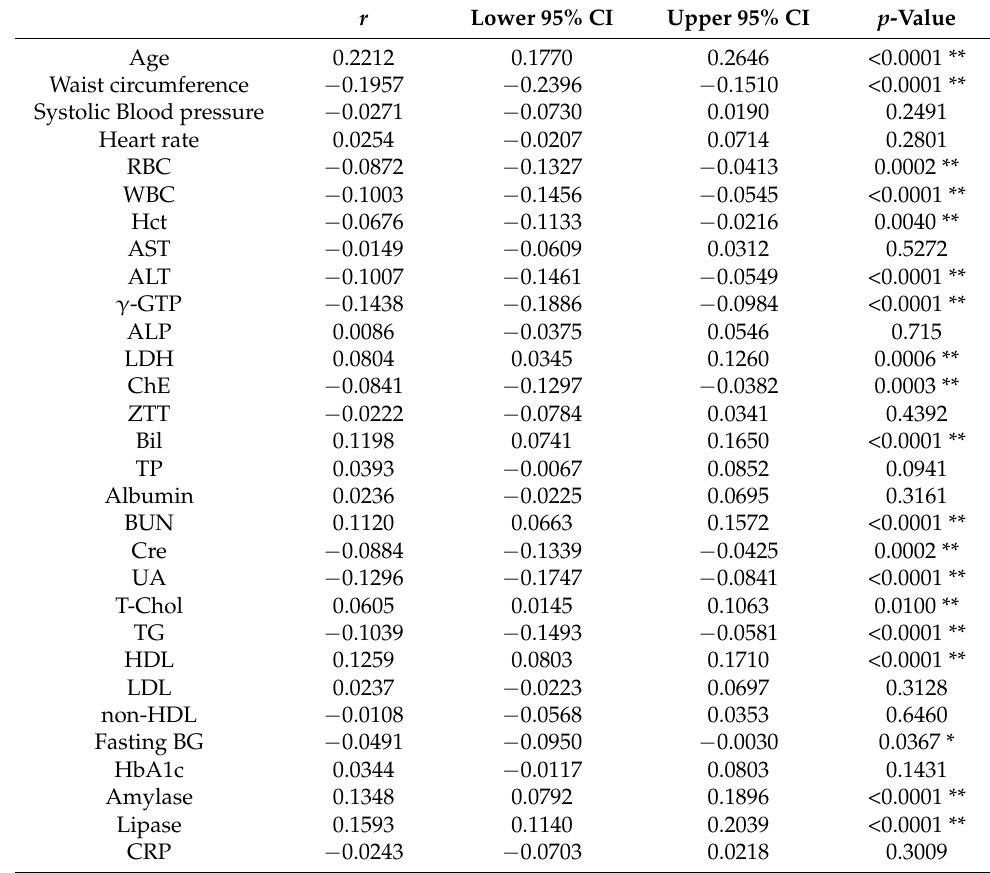
Table 4. Associations among skin carotenoid levels and various continuous